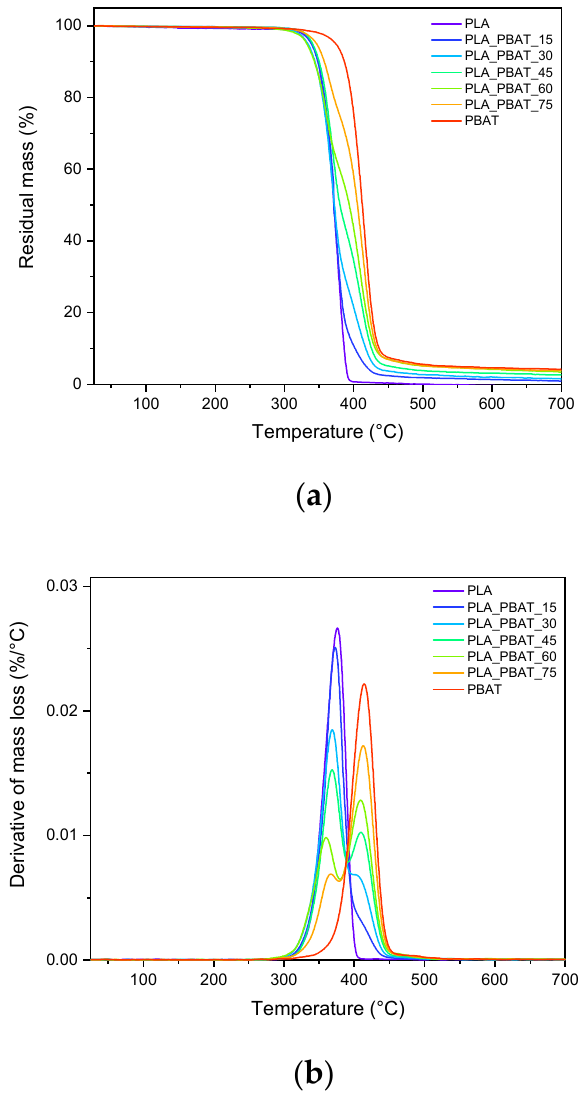
Figure 5. TGA thermograms of neat PLA, neat PBAT and their blends. Trends of ( a ) residual mass and ( b ) mass loss derivative as a function of temperature. Table 2. Results of the TGA tests on neat PLA, neat PBAT and their blends.